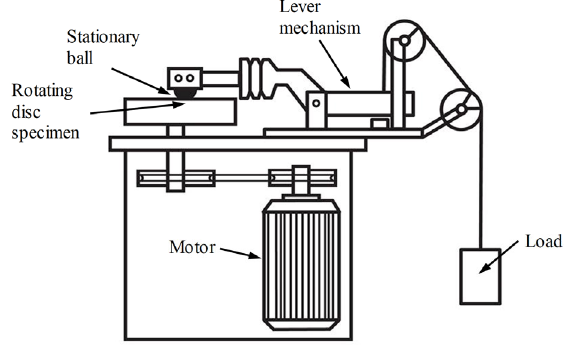
Fig. 2 Schematic diagram of a ball-on-disc tribometer.